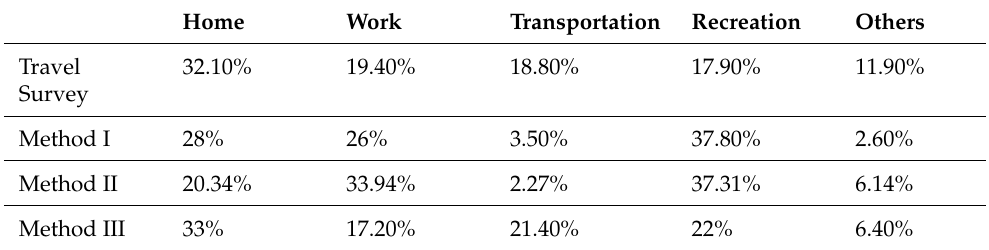
Table 4. Activity proportions of the three methods and travel survey